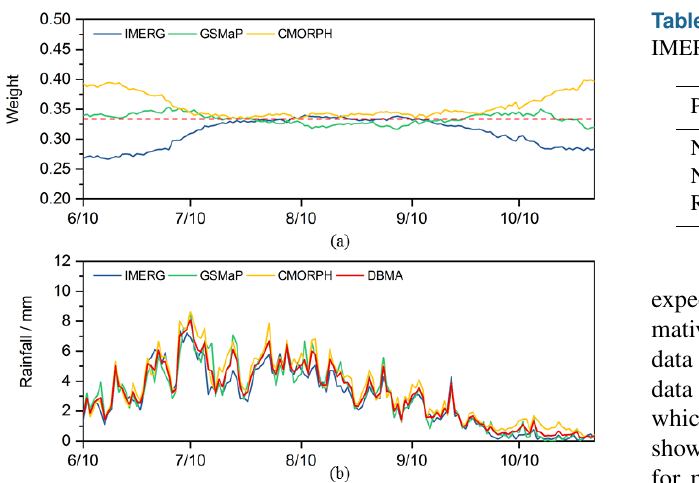
Figure 4. Seasonal variations in basin-averaged (a) weights and (b) rainfall estimates of the multiyear daily values of IMERG, GSMaP, CMORPH and DBMA.